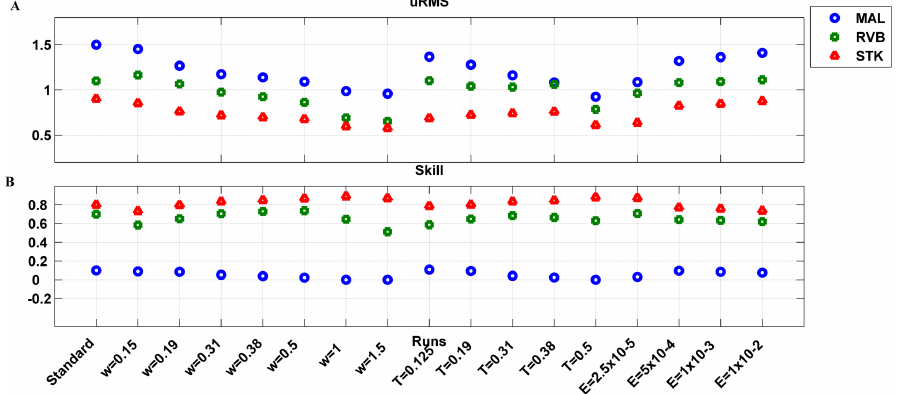
Figure 6. Statistical metrics for sensitivity runs. (a) Unbiased root mean square and (b) skill. On the x axis are the different runs. Colored symbols are stations RVB (green square), STK (red triangle) and MAL (blue